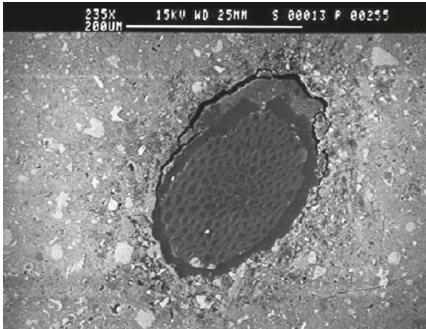
Figure 6: SEM image of a coir fiber–reinforced cement composite showing the effect of water absorption [76]. Reproduced with permission from